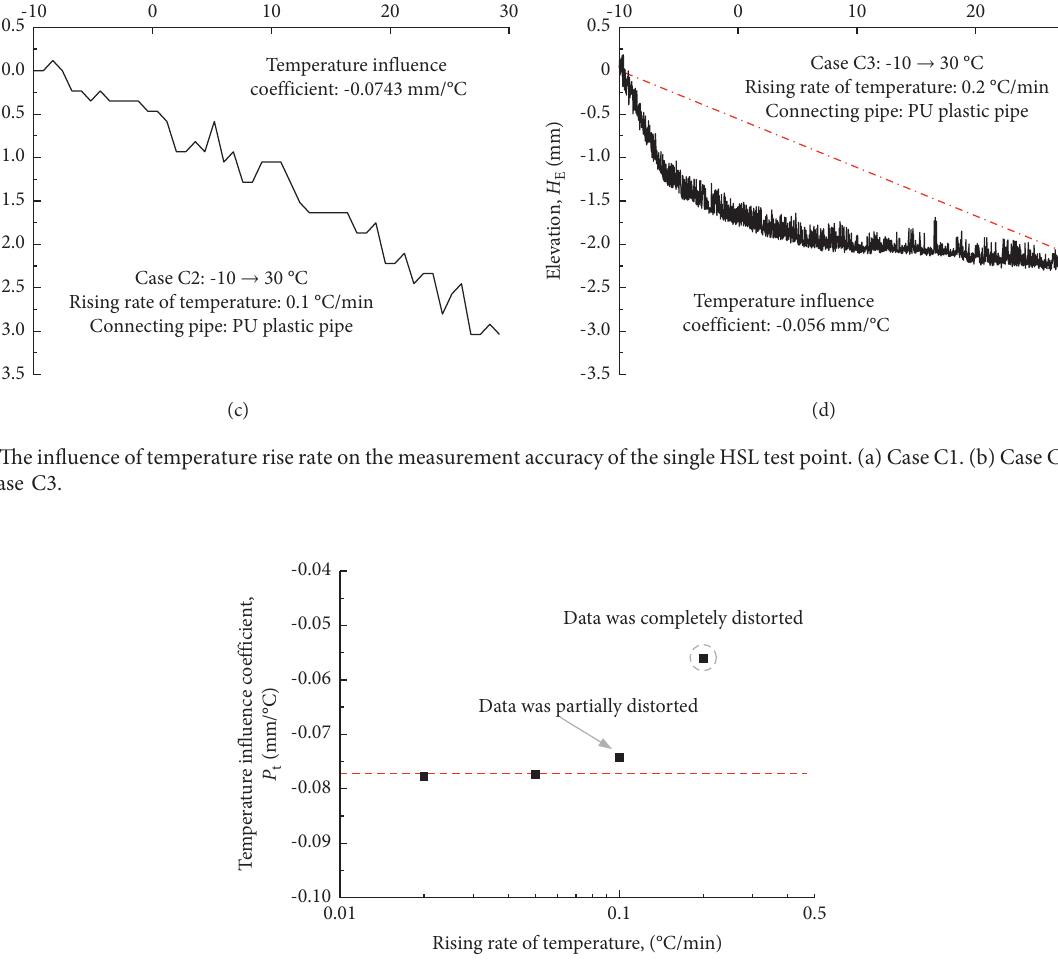
Figure 4: The relationship between temperature influence coefficient and temperature rise rate.